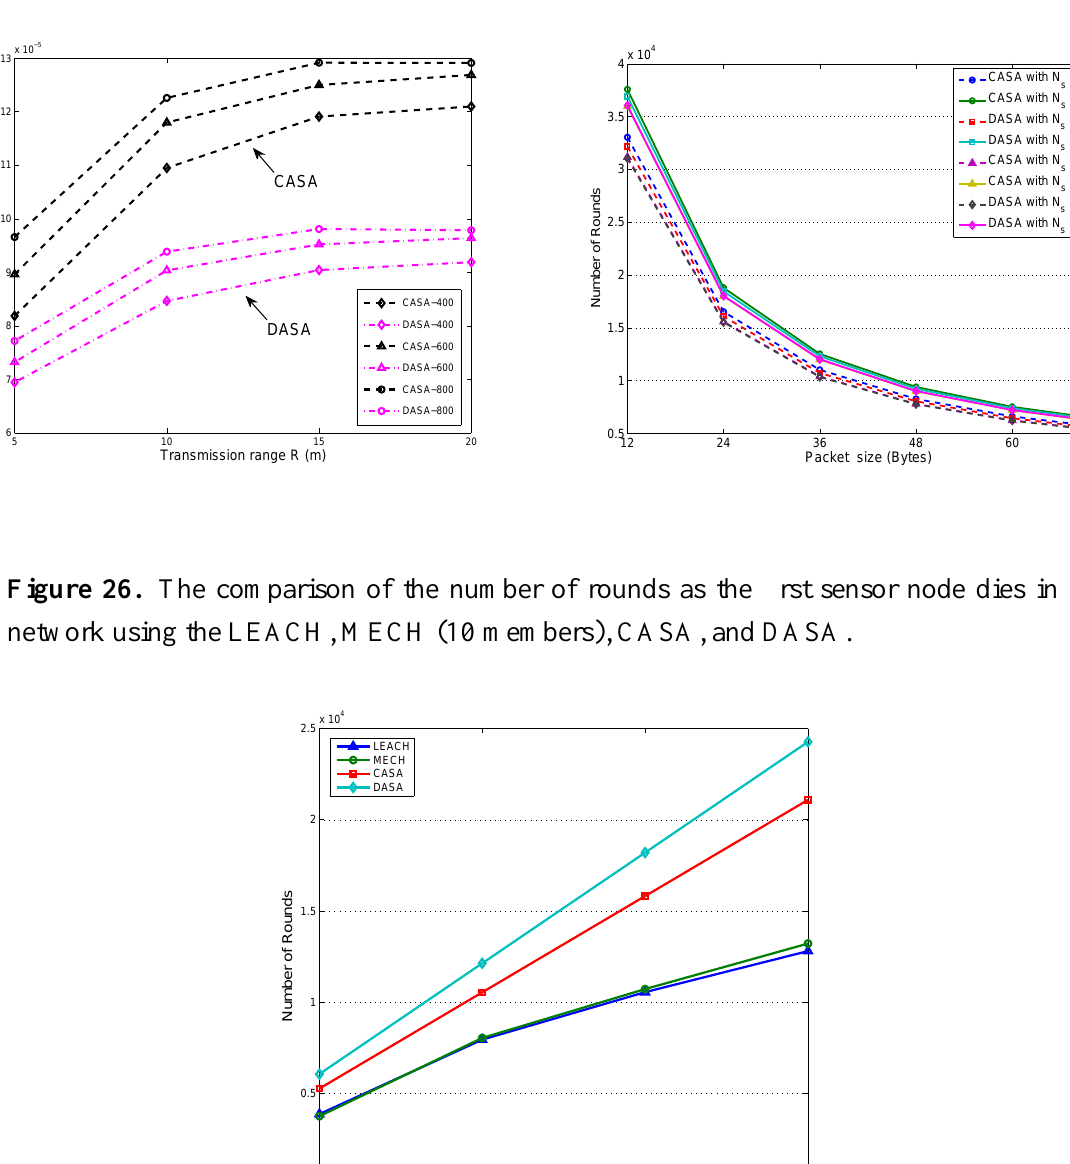
Figure 25. The relationship between energy consumption per round (Joules) and transmis- sion range R (left); the number of sensing rounds with varying the size of data packet (right).